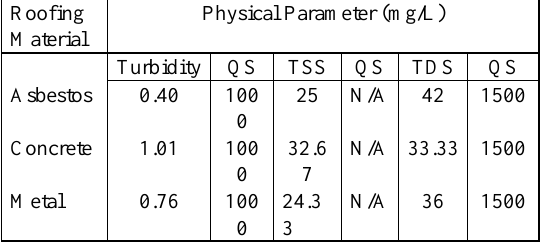
Table 2: Results for Physical Parameters